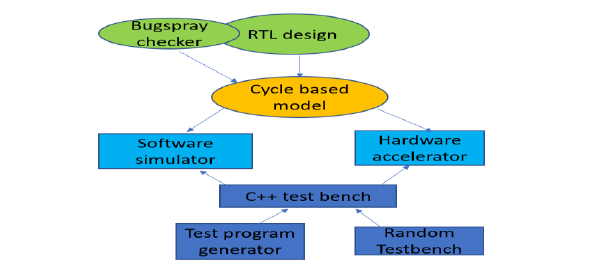
Figure 4. Pre silicon verification